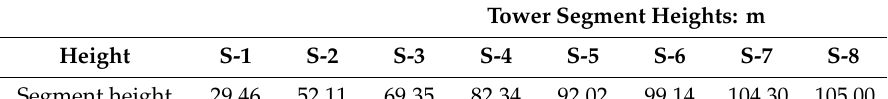
Table 3. Segment heights of 105 m lattice tower.